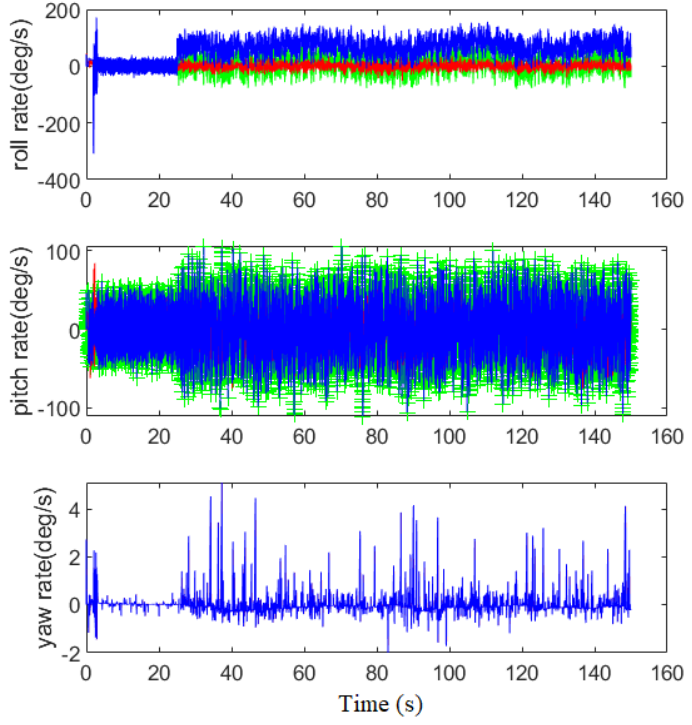
Figure 17. Bias fault: angular rate estimation (red line–estimated signal,blue line–faulty signal, green line–actual signal without fault occurrence).